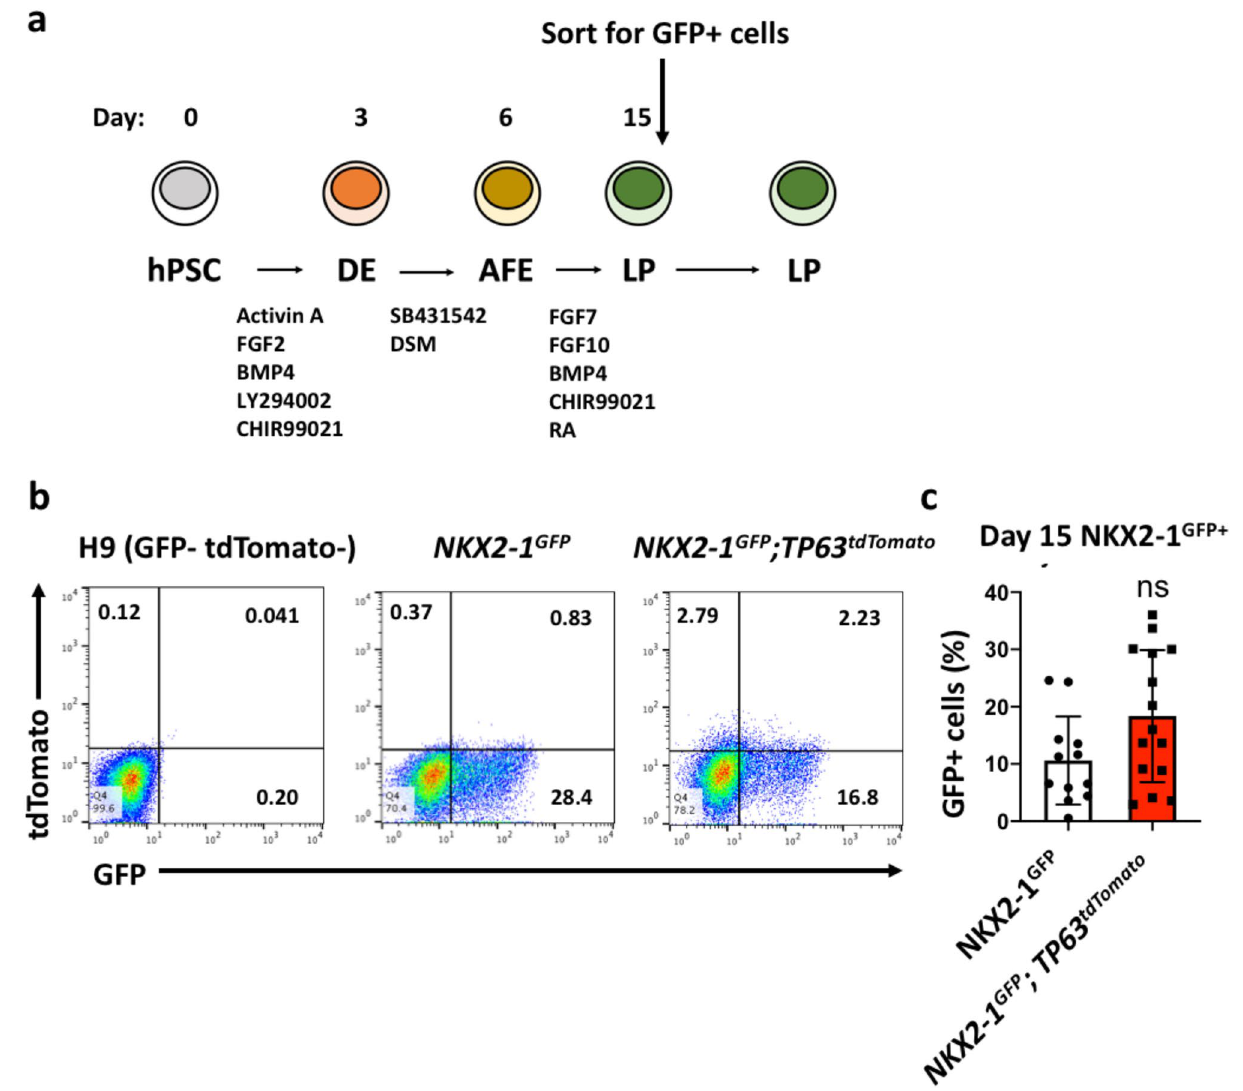
Figure 2. Assessment of tdTomato reporter functionality. ( a ) Schematic of lung differentiation protocol based on the work of McCauley et al . (2017) 38 . hPSC: human pluripotent stem cell; DE: definitive endoderm; AFE: anterior foregut endoderm; LP: lung progenitor. ( b ) Flow cytometry analysis of GFP + tdTomato + cells at Day 15 of the differentiation protocol. Representative dot plot shown. ( c ) Quantification of NKX2-1 GFP+ cells at Day 15 as a measure of lung differentiation efficiency. Data are represented as means ± SD, n = 11 ( NKX2-1 GFP ), n = 15 ( NKX2-1 GFP ; TP63 tdTomato ). ns, not statistically significant. t test. Graph was made and statistical analysis was done using GraphPad Prism 8.0 (GraphPad Software Inc., San Diego, CA, USA) (www.graph